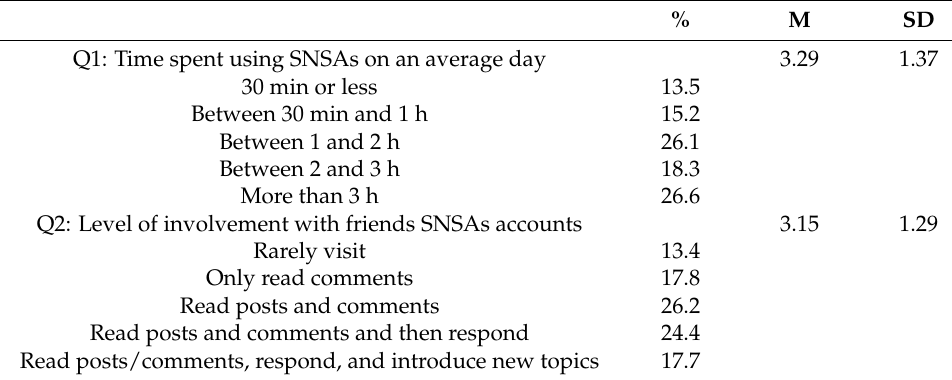
Table 1. Intensity of SNSAs